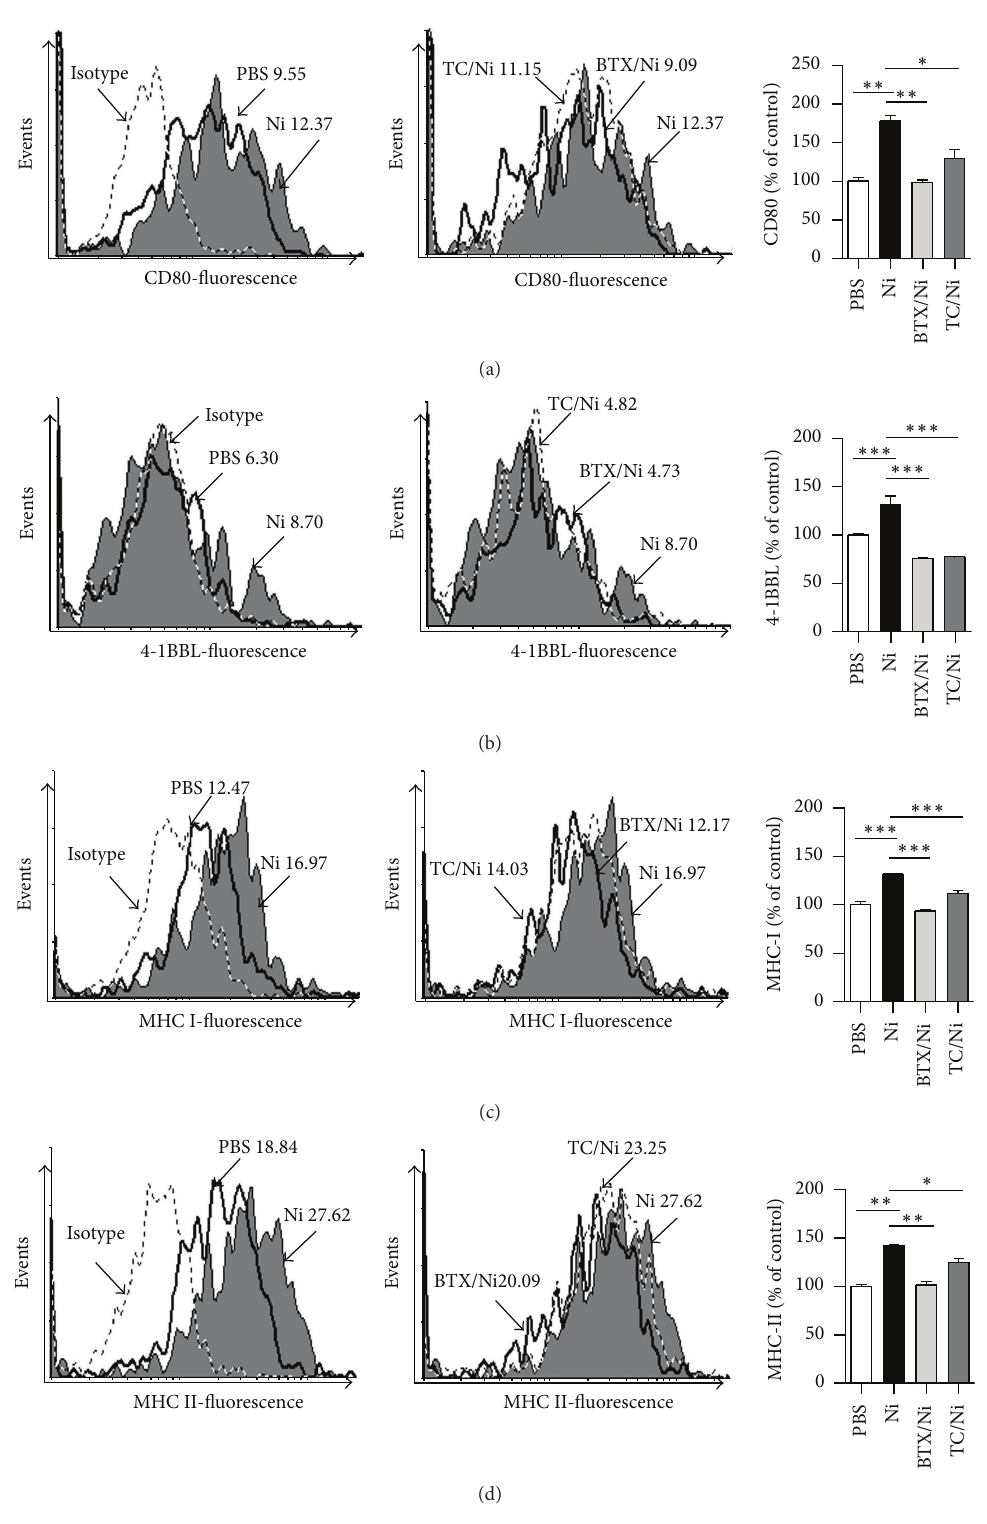
Figure 1: Nicotine upregulates surface molecules expression in human semimature DCs. (a–d) DCs derived from human PBMC with 100ng/mL recombinant human GM-CSF and IL-4 were conferred with 𝛼 -bungarotoxin (2 𝜇 g/mL) or tubocurarine chloride (4 × 10 −5 mol/L) 2 h prior to nicotine (10 −7 mol/L) 12 ∼ 15h stimulation. The effect of nicotine on the expression of CD80 (a), 4-1BBL (b), MHC class I (c), and MHC class II (d) molecules was determined by flow cytometry. Numbers in histogram indicated mean fluorescence intensity (MFI) of test samples. Data were given as mean ± SEM, one-way ANOVA with post-Newman-Keuls test. ∗ 𝑃 < 0.05 , ∗∗ 𝑃 < 0.01 , and ∗∗∗ 𝑃 < 0.001 . One representative from 3 independent experiments is shown. Ni: nicotine; BTX: 𝛼 -bungarotoxin; and TC: tubocurarine